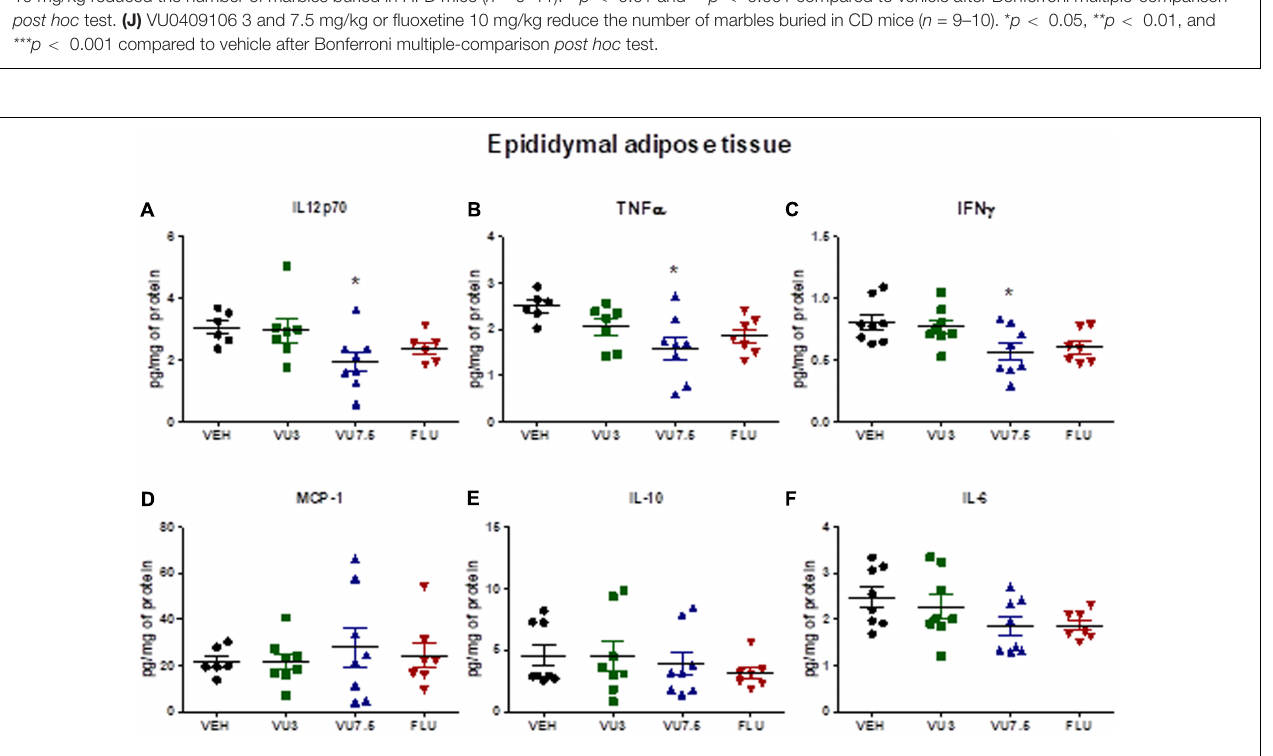
FIGURE 2 | Effects of 14 days’ treatment on body weight, cumulative intake, and behavioral tests in HFD mice and CD mice. Scatter plot representation. (A) Treatment with VU0409106 7.5 mg/kg or fluoxetine 10 mg/kg reduced body weight of HFD mice ( n = 8–9). (B) Food intake of HFD mice is decreased after treatment with VU0409106 7.5 mg/kg or fluoxetine 10 mg/kg ( n = 8–11). (C) Graphical representation showing 14 days’ treatment on body weight of HFD mice. Treatment with VU0409106 (3 or 7.5 mg/kg) or fluoxetine (10 mg/kg) did not reduce body weight (D) or food intake (E) of CD mice ( n = 8–11). (F) Graphical representation showing 14 days’ treatment on body weight of CD mice. (G) Treatment with VU0409106 7.5 mg/kg did not alter the distance traveled of HFD mice ( n = 6–8). * p < 0.05, **p < 0.01, and ***p < 0.001 compared to vehicle after Bonferroni multiple-comparison post hoc test. (H) Treatment with VU0409106 (3 or 7.5 mg/kg) or fluoxetine (10 mg/kg) on CD mice did not change the distance traveled comparing to the control group. (I) VU0409106 7.5 mg/kg or fluoxetine 10 mg/kg reduced the number of marbles buried in HFD mice ( n = 9–11). ** p < 0.01 and *** p < 0.001 compared to vehicle after Bonferroni multiple-comparison